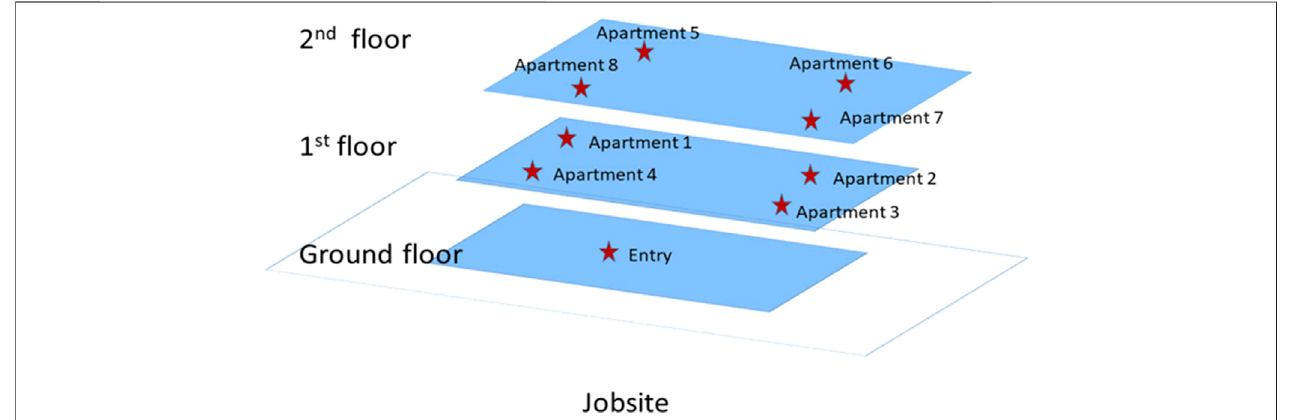
FIGURE 2 | A simpli fi ed fl oor plan, with gateways marked on-site.